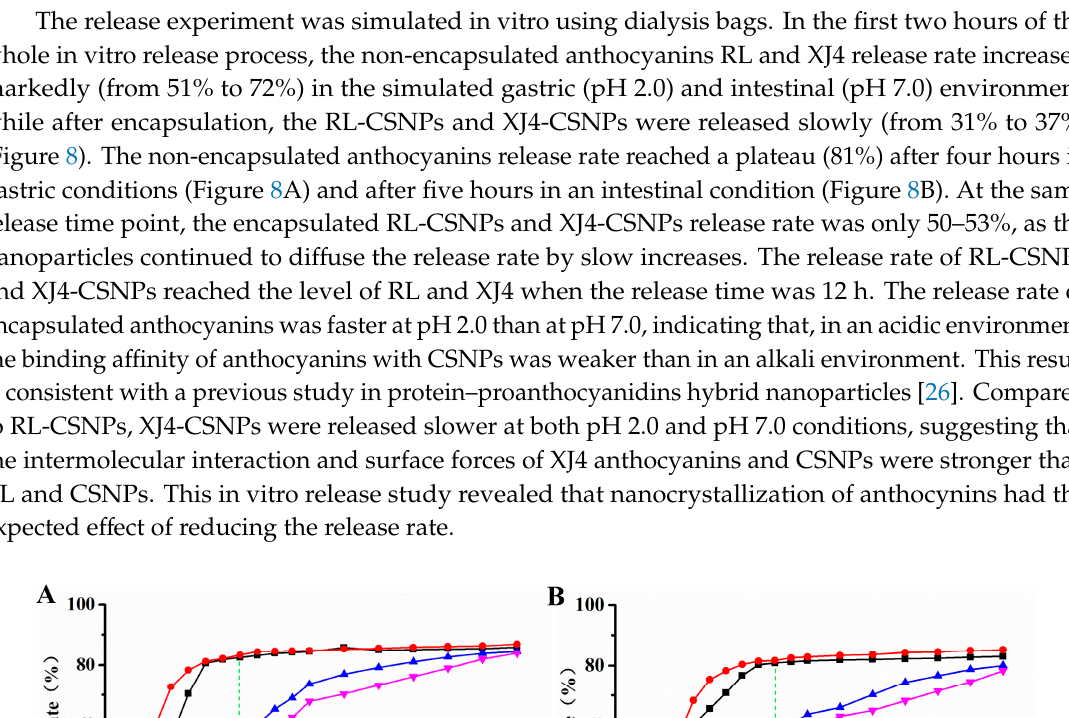
Figure 7. DPPH free radical scavenging ability of nanoparticles in different stress conditions. ( A ) Ultraviolet light exposure time; ( B ) pH; ( C ) temperature; ( D ) salt.